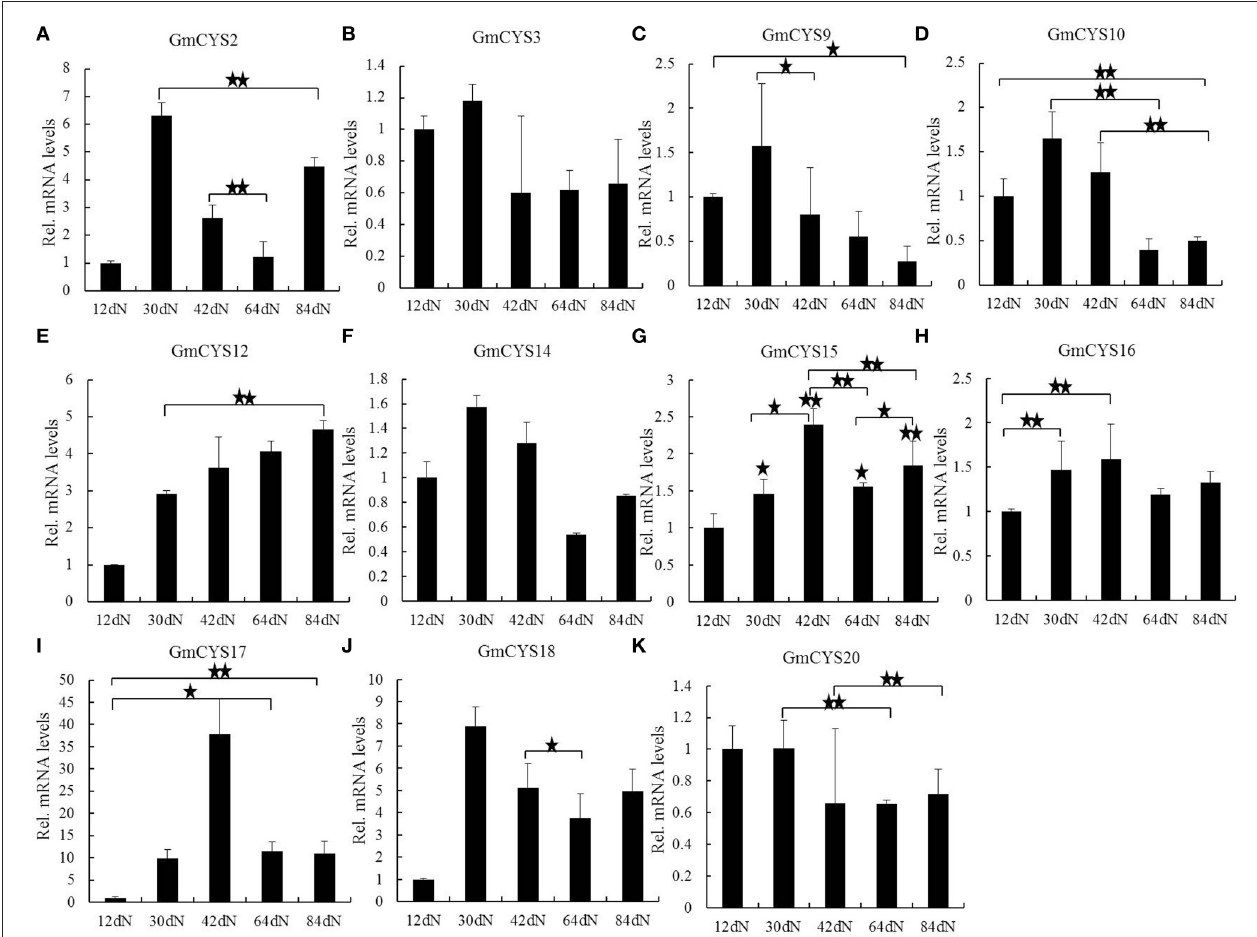
FIGURE 5 | Expression profile of cystatins family genes in soybean nodules at five important nodule development time points. Three biological replica samples and three replicate reactions per sample were used to calculate the expression level of each cystatin during the nodule development. Relative expression levels of each cystatin gene were obtained by qPCR and normalized to the average expression level of soybean reference gene QACT, and calculated using the expression level in 12 dN as a starting point control. Data represent the mean ± SE of nine independent replicate experiments. “ ⋆ ”and “ ⋆⋆ ” indicate statistical difference between different nodule development time points ( t -test, p < 0.05 or p < 0.01, respectively). “ ⋆ ”and “ ⋆⋆ ” without wire frame marker in (G) , indicate statistical difference compared to the 12 dN (starting point control). (A) GmCYS2. (B) GmCYS3. (C) GmCYS9. (D) GmCYS10. (E) GmCYS12. (F) GmCYS14.